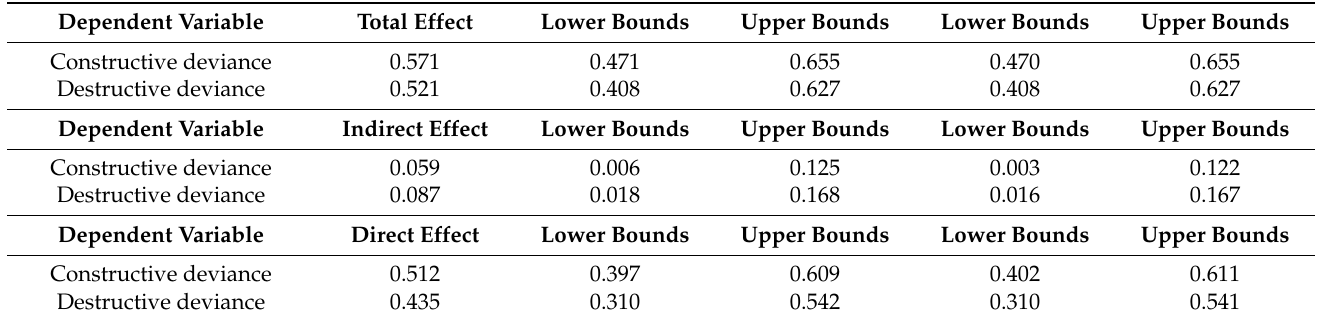
Table 6. Sectional test of mediation